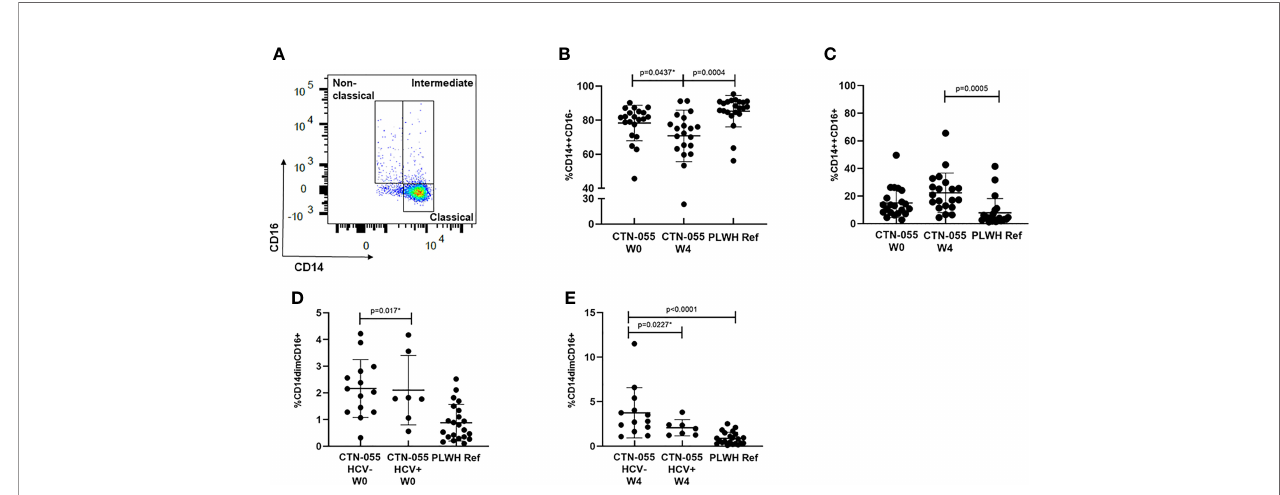
FIGURE 4 | Alcohol-use disorder Among PLWH is associated with altered monocyte phenotype. Boolean gating was applied to total live, CD3-/CD56-/CD19-/ CD14+ cells to calculate frequencies of classical, intermediate, and non-classical monocytes (A) among CTN-055 participants at W0 (n = 21) and W4 (n = 20), and PLWH ref. population (n = 22). Means with SD are shown for each monocyte phenotype from all participants (B – E) . See Supplemental Figure 1 for complete gating strategy. *indicates unadjusted